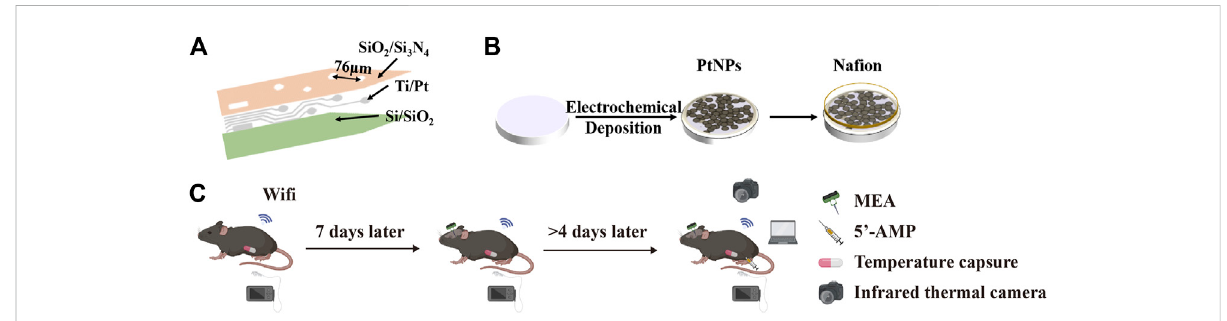
FIGURE 1 Schemeofourwork. (A) StructurediagramofMEAincludingSi/SiO 2 (25 μ m/200 nm),Ti/Pt(30nm/250 nm),andSiO 2 /Si 3 N 4 (500nm/300 nm). (B) SchemefordepositionofPtNPsandNa fi onontothemicroelectrodes. (C) Schematicdiagramoftheexperimentalprocess,includingimplantation and recording of temperature capsule and